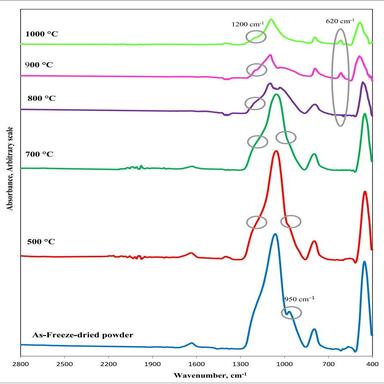
FT-IR spectra of as-Freeze dried silica and after samples calcined at 500 ◦C, 700 ◦C, 800 ◦C, 900 ◦C, and 1000 ◦C.